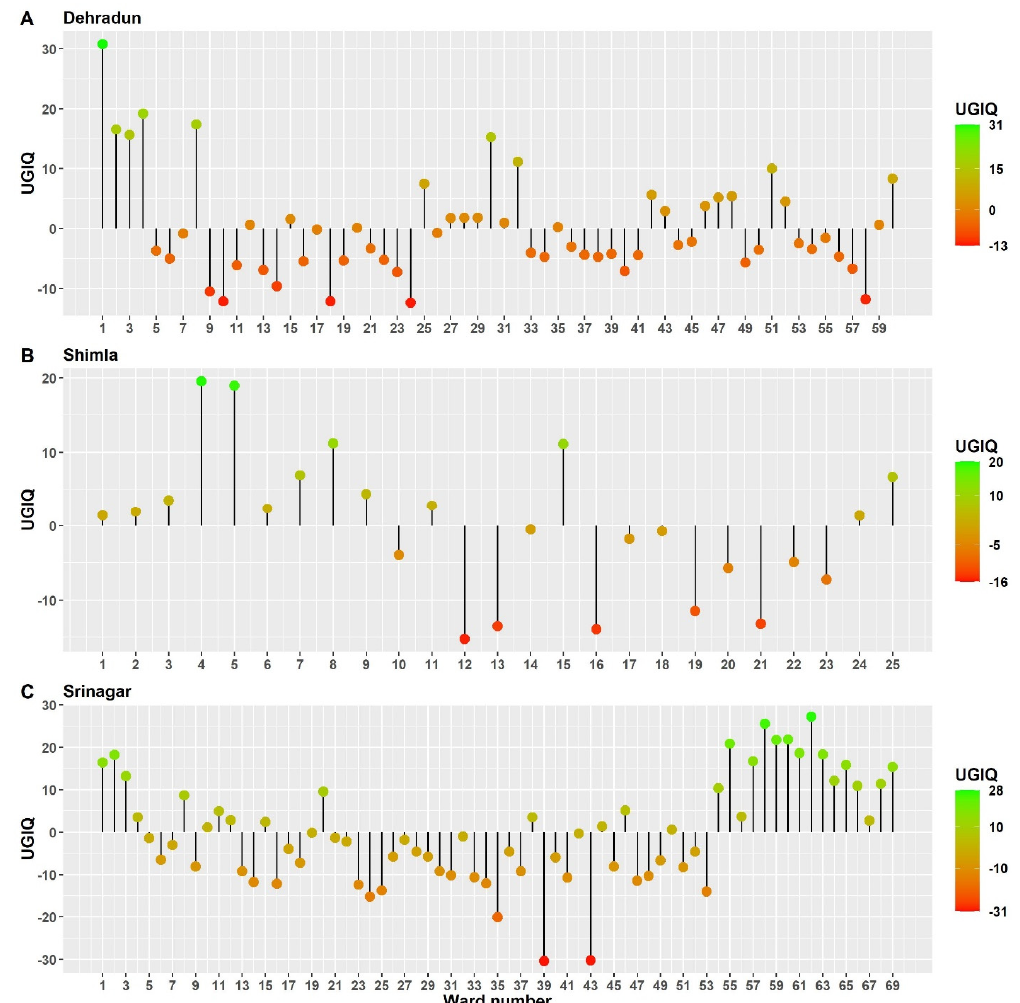
Figure 8. UGIQ variation and distribution of UGI according to ward number in three cities.